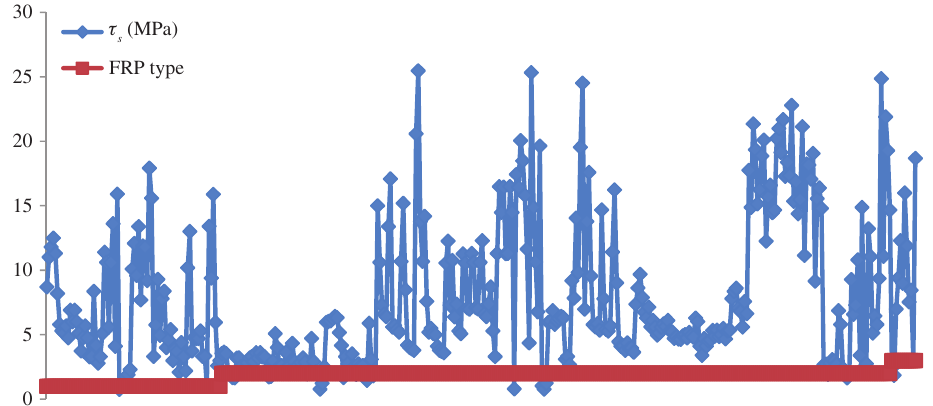
Figure 24: Change in the bond strength of FRP bars in concrete with changing FRP